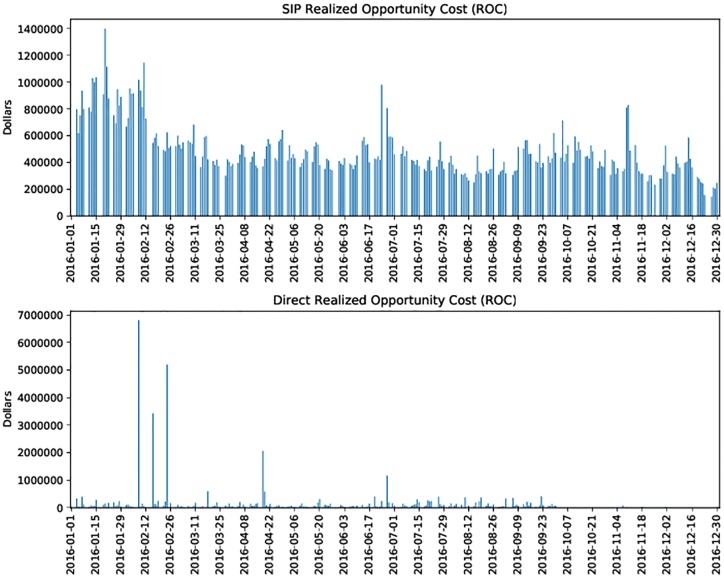
Daily ROC during calendar year 2016 aggregated across all tickers.A large majority of days favored the direct data feeds. Both Direct and SIP ROC time series show signs of decay across 2016, which may be due to infrastructure improvements.